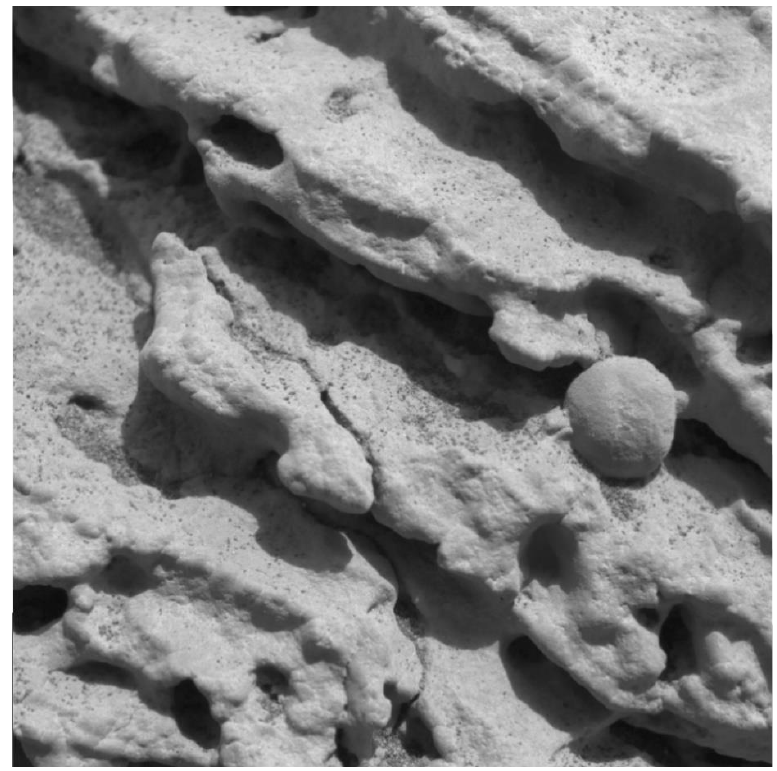
Figure 21. Close-up of a rock outcrop.